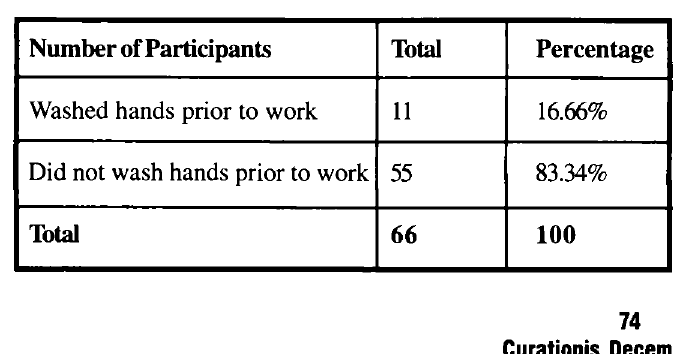
Table 1 : Hand decontamination at the start of